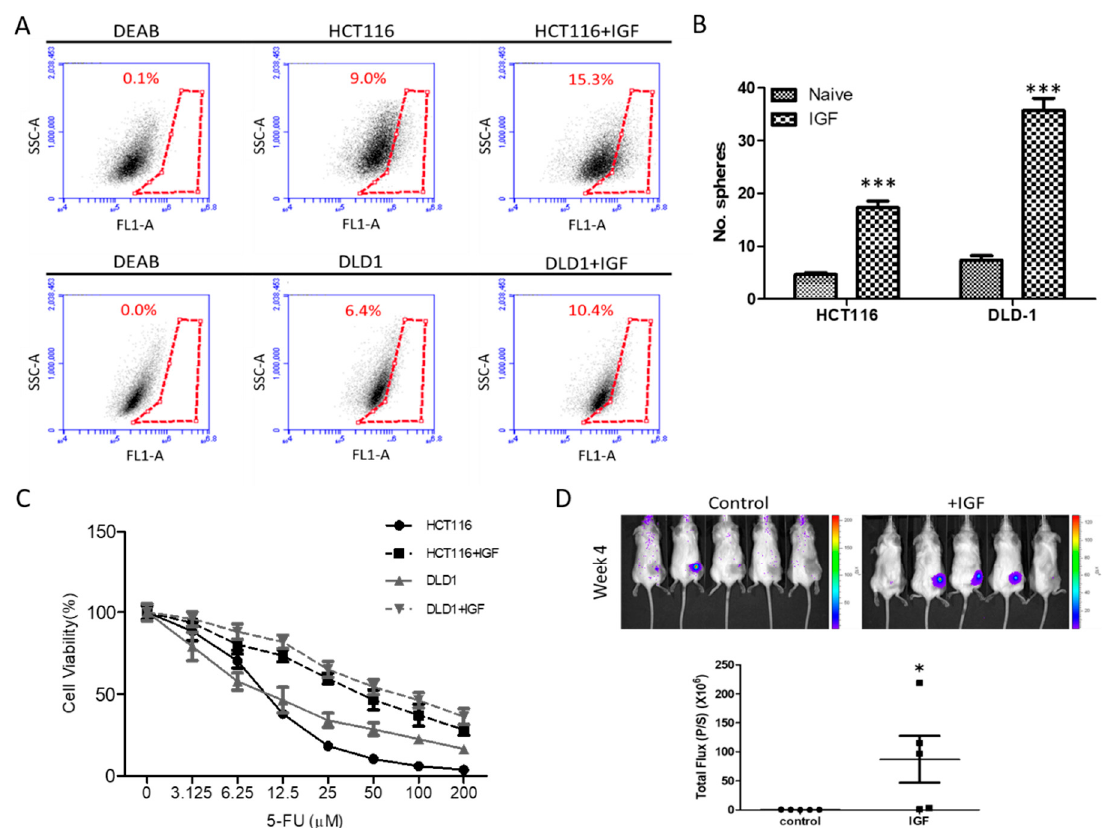
Figure 1. IGF1 promotes the generation of cancer stem-like (CSC) colon cancer cells. ( A ) Flow cytometry analysis showed that IGF1-treated colon cancer cells exhibited significantly higher ALDH1 activity. The DEAB Inhibitor of the ALDH enzyme was used as a control for ALDH1 analysis. ( B )